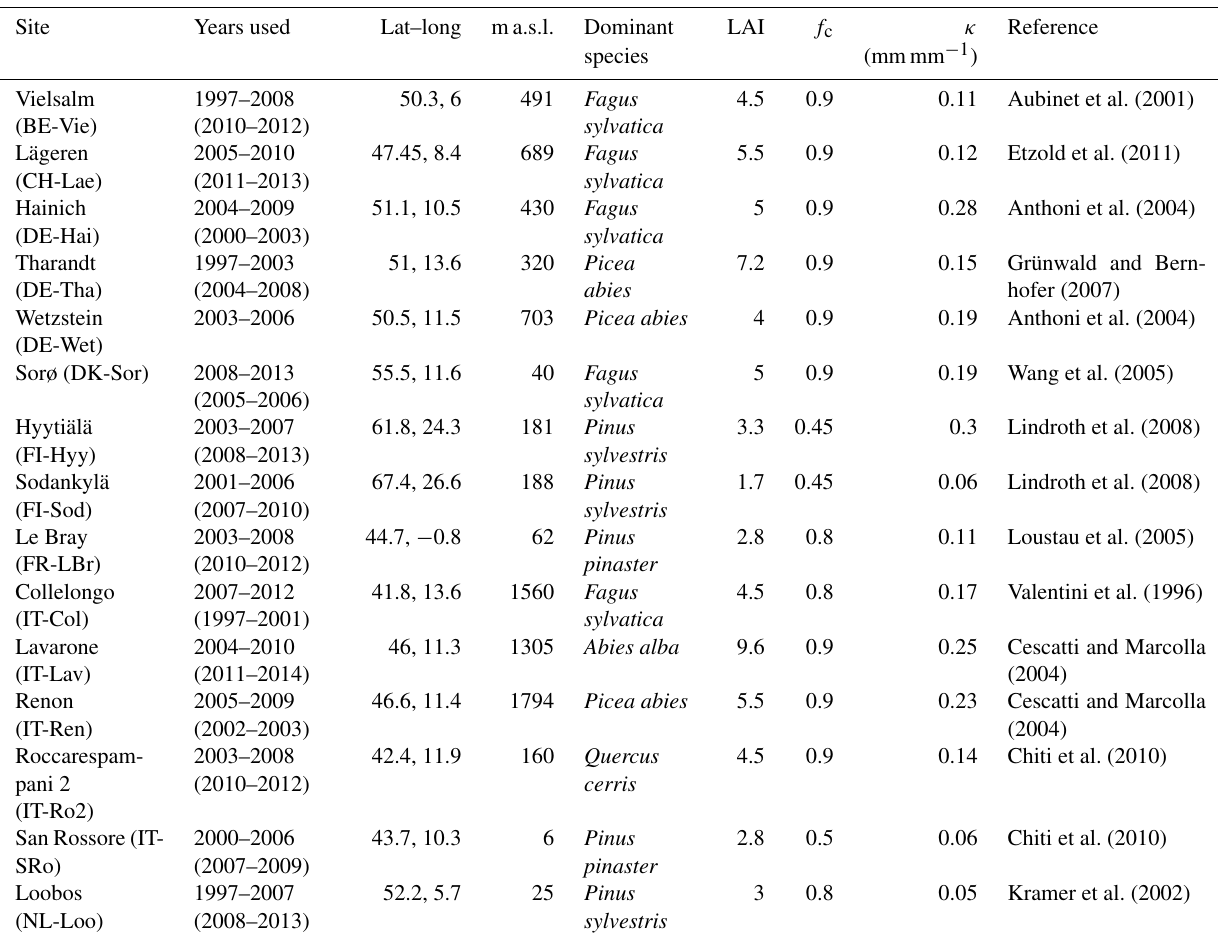
Table 2. Overview of the FLUXNET sites used in this study. Where a model validation was performed, the validation period is given in brackets. LAI refers to the value at full